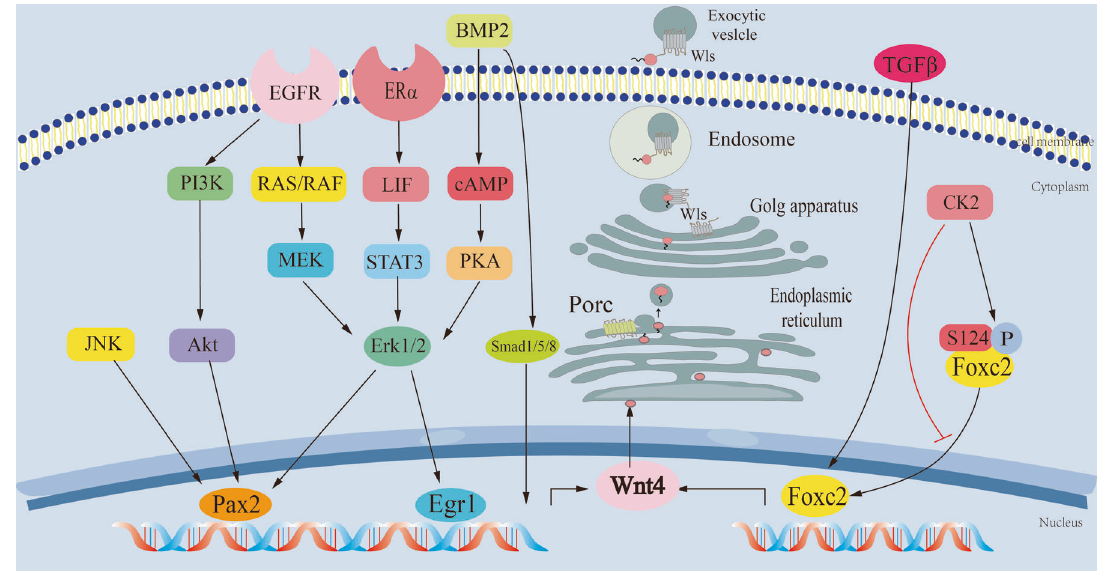
Fig. 1 The upstream regulator of WNT4 and its transport mechanism in cells. EGR1, PAX2, and FOXC2 are three veri fi ed transcription factors that bind to the WNT4 promoter to increase its transcription. The reported upstream signaling pathways include ER α -LIF-STAT3-ERK1-EGR1, BMP2-cAMP-PKA-ERK1, RAS-RAF-MEK1/2-ERK1-EGR1, PI3K-AKT-PAX2, ERK1-PAX2, JNK-PAX2, TGF β -FOXC2, and CK2/p-FOXC2. The cysteine-rich protein WNT4 can be modi fi ed with palmitoleic acid at Ser 212 by porcupine in the endoplasmic reticulum, where it is chaperoned to the cell membrane and secreted by interacting with WNTless/Evi